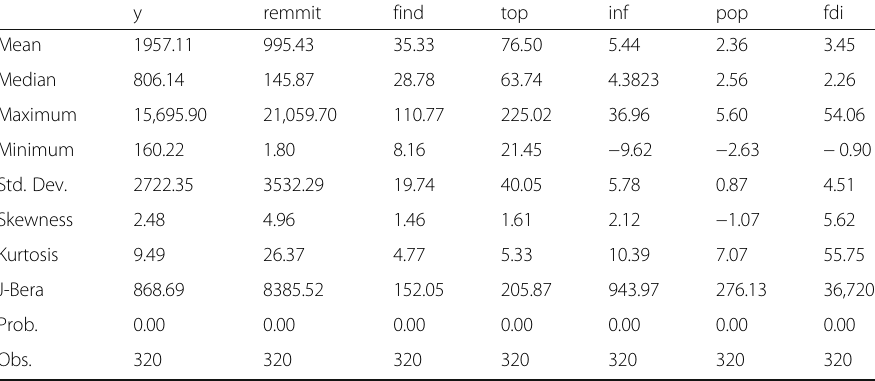
Table 4 Descriptive Statistics of selected variables